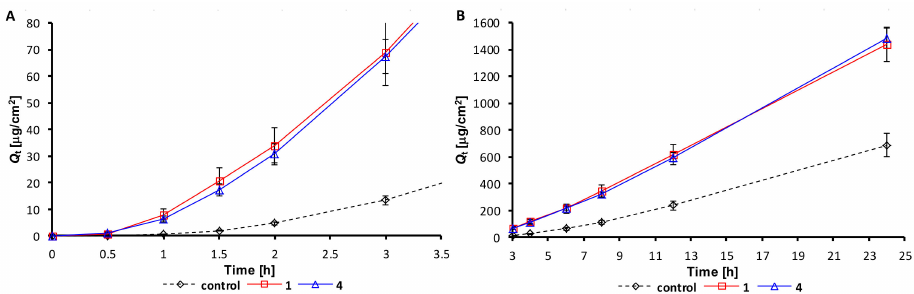
Figure 2. In vitro profile of cumulative permeated amounts Q t per unit area [ µ g/cm 2 ] of theophylline alone (control) and after addition of alaptide ( 1 ) and other tested non-spirocyclic compounds 2 – 5 in ratio 10:1 from propylene glycol/water 1:1 system through the skin in time. Q t values are expressed as mean ± SD ( n = 5 experiments).